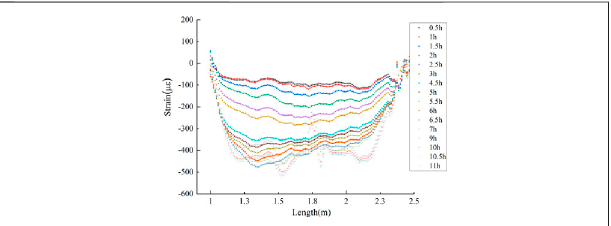
FIGURE 8 | Strain distribution measured by the optic fi ber at 6 o ’ clock